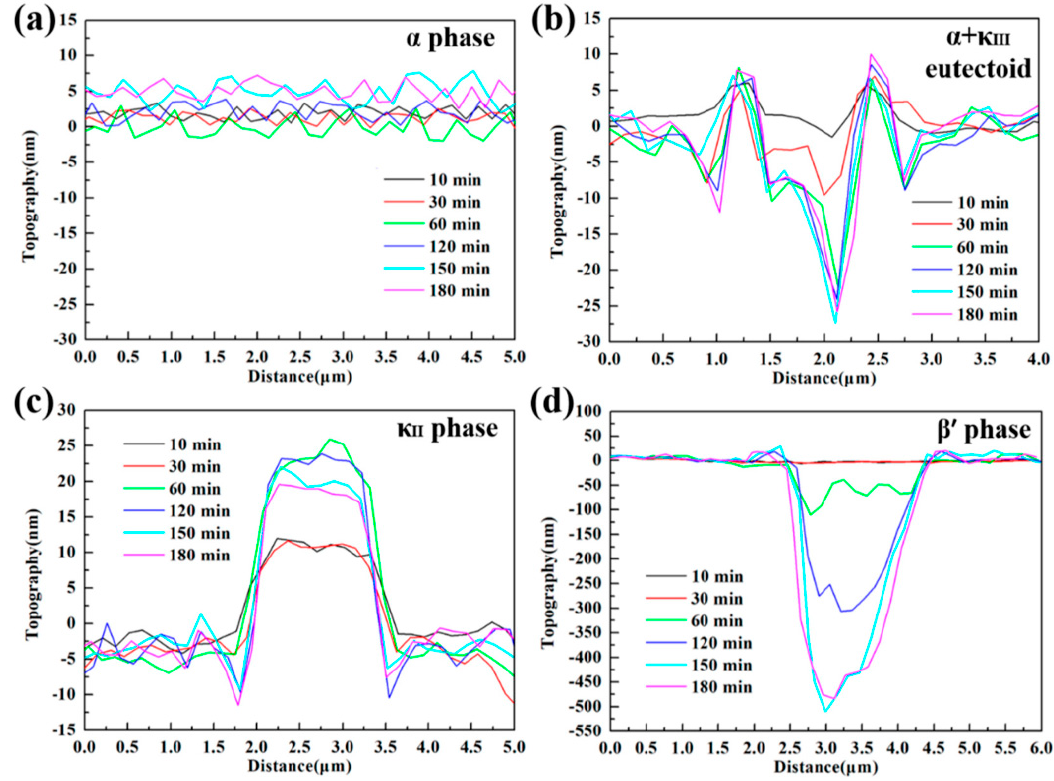
Figure 7. In situ line profiles corresponding to sites 1, 2, 3, and 4 marked in Figure 6, respectively: ( a ) α phase; ( b ) α + κ III eutectoid structure; ( c ) κ II phase; ( d ) β ’ phase. Reprinted with permission from